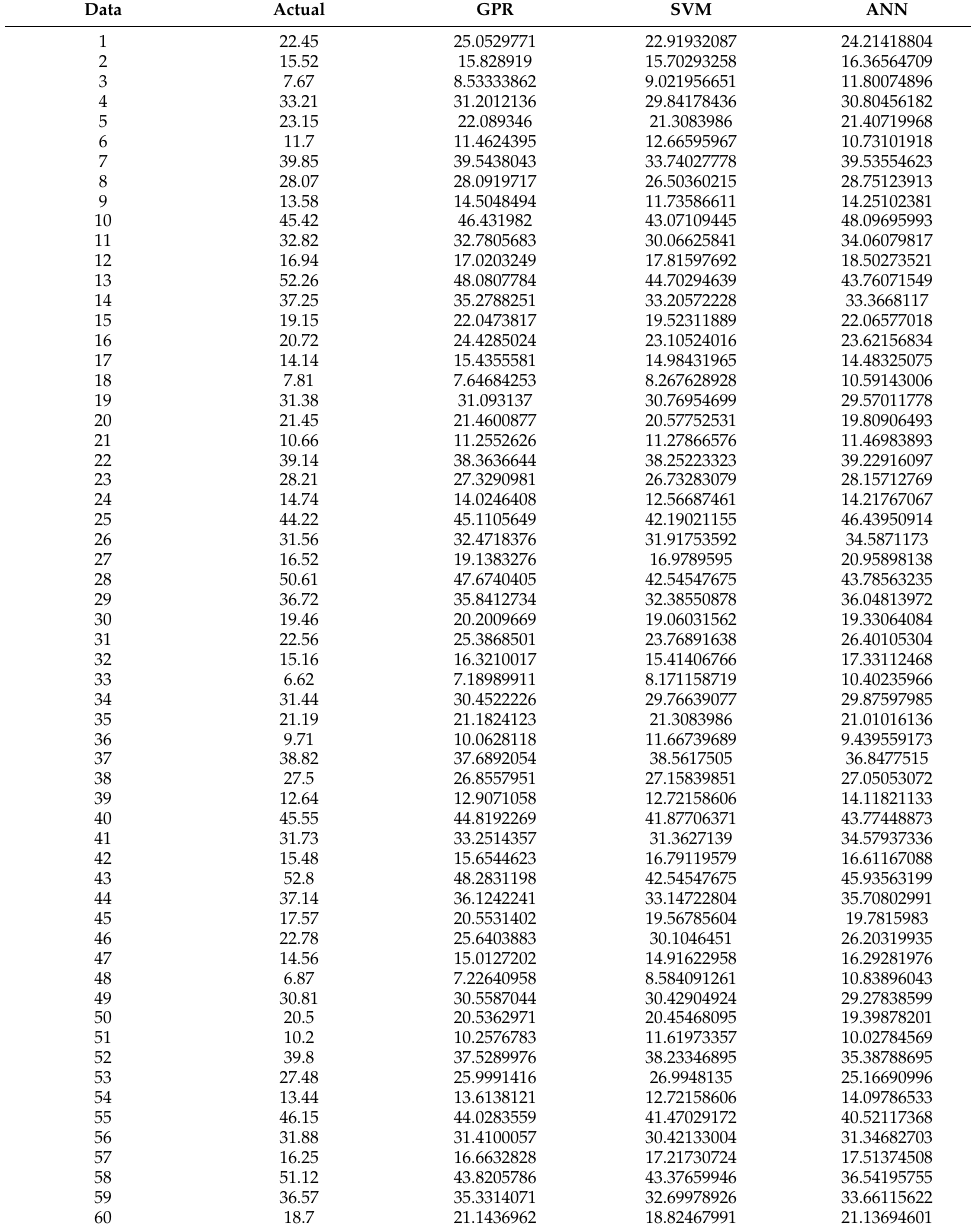
Table 3. Comparison results of F c ( N ) for actual cutting forces, GPR, SVM, and ANN measured in